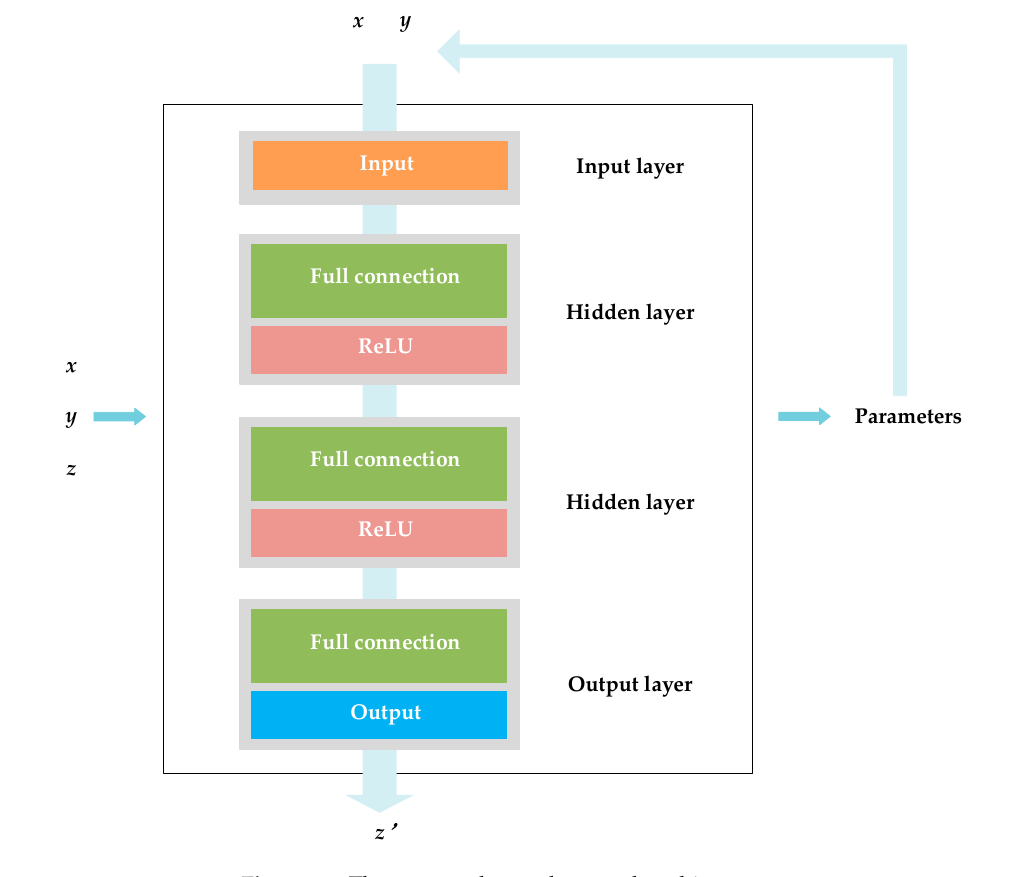
Figure 10. The proposed neural network architecture.